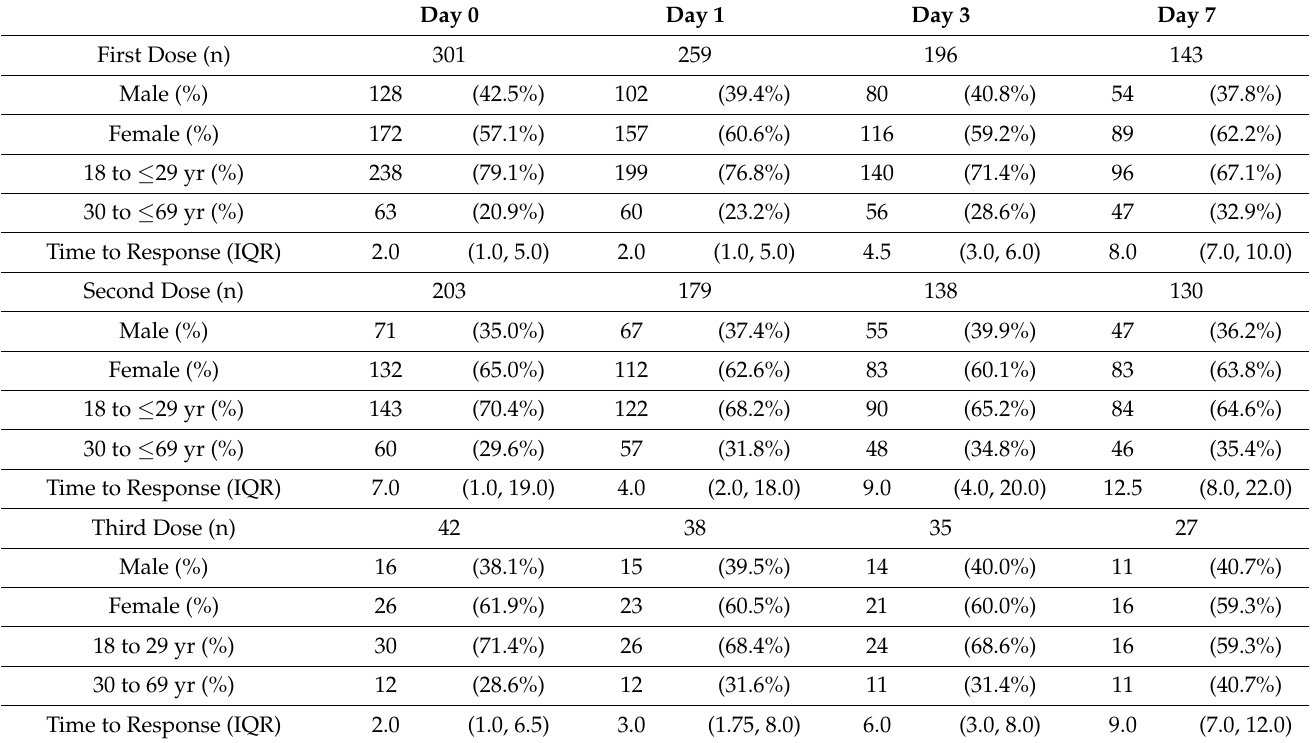
Table 1. Demographic characteristics. IQR: interquartile range. Day 0 is defined as the day of immunization. Time to Response is defined as the number of days between immunization (day 0) and response